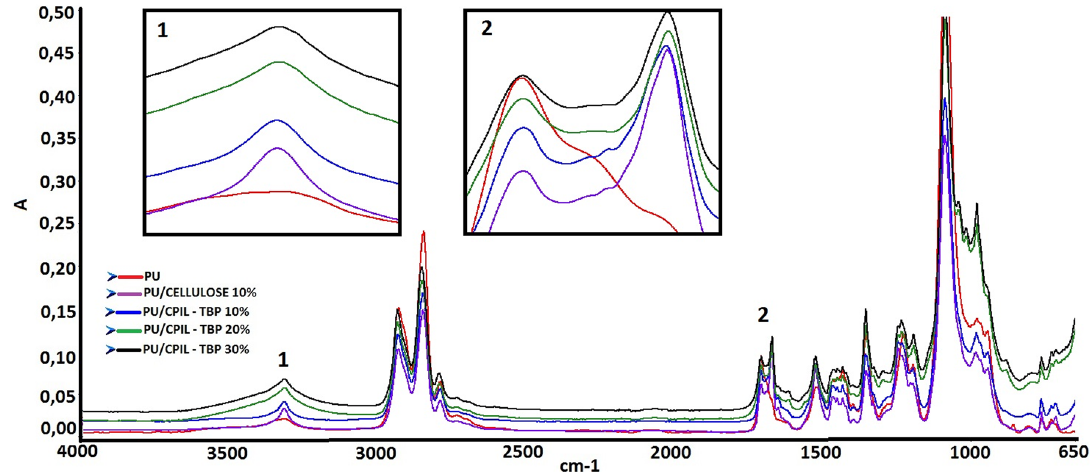
Figure 3. FTIR spectra of PU and PU composites